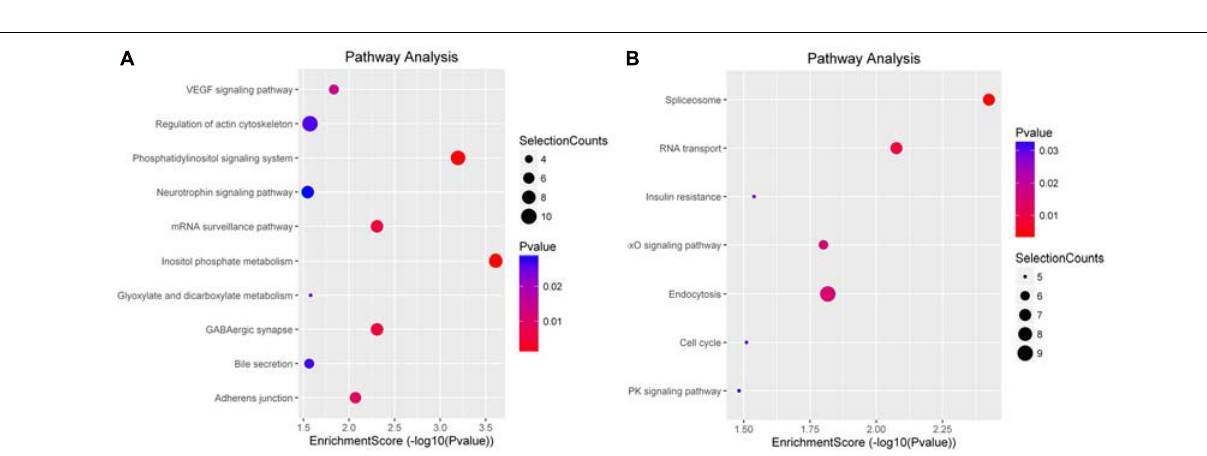
FIGURE 5 | KEGG enrichment analysis of differentially expressed miRNAs. (A) Target genes of M-EXO (miR-183, miR-425-3p, miR-1249, miR-451, miR-146a-5p, miR-221-5p); (B) Target genes of A-EXO (miR-28-5p, miR-145-5p, miR-149, miR-186, miR-499-5p).